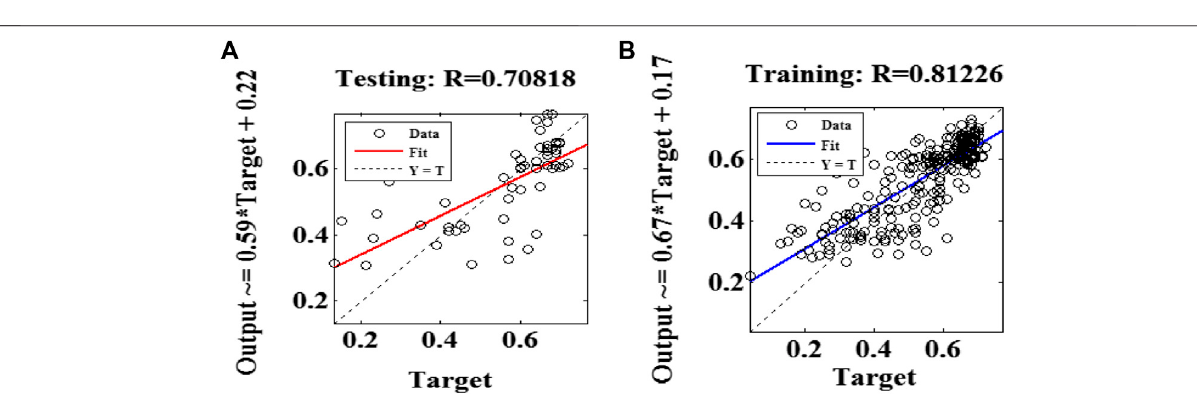
FIGURE 7 | (A,B) Training and testing plots based on ANFIS